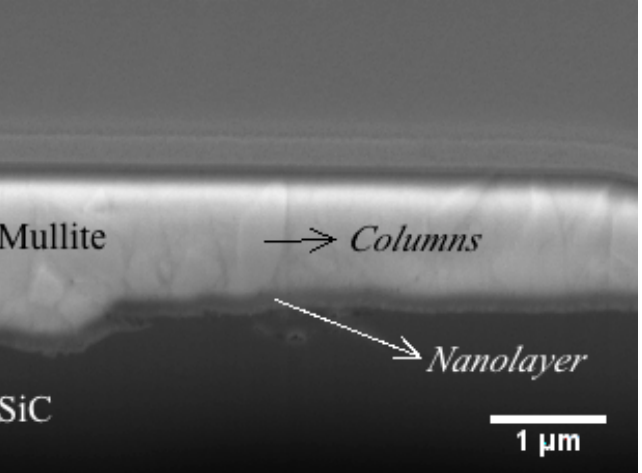
Figure 1. FIB cross section of a polished film. The columnar microstructure and nanolayer are indi- cated.